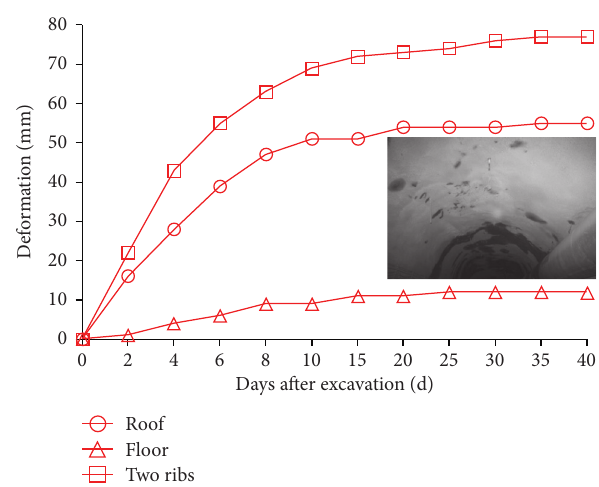
Figure 6: The deformation curve and the image of the completed optimization.